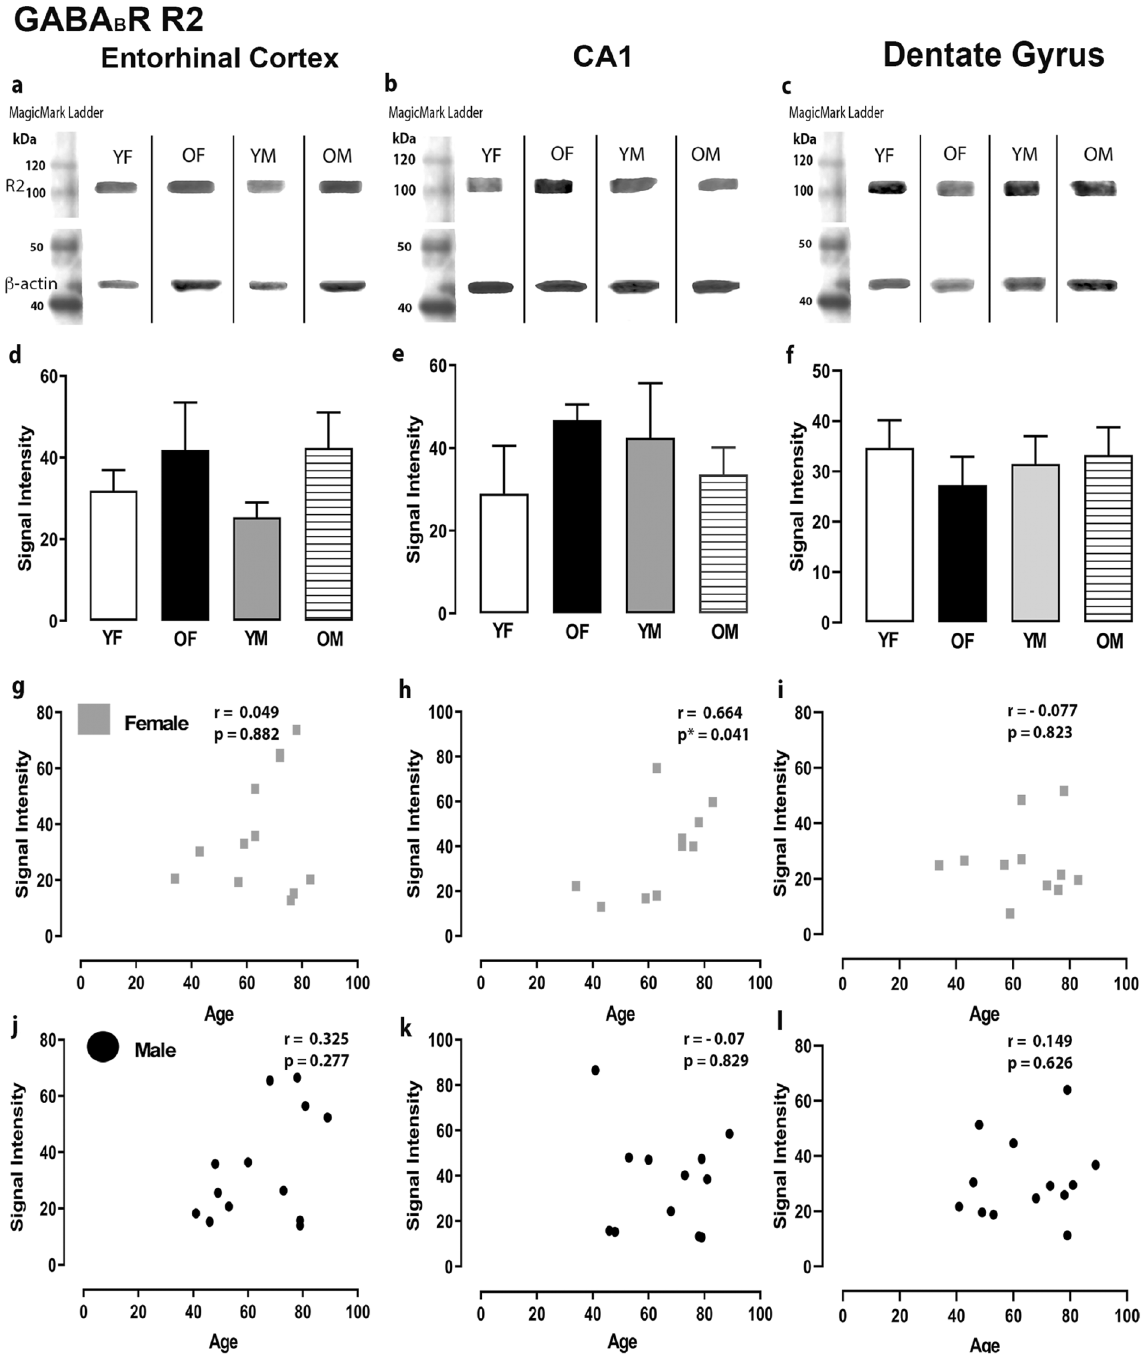
Figure 5. Expression of the GABA B R R2 subunit in the entorhinal cortex, hippocampal CA1 region and dentate gyrus. ( a,b,c ) Representative immunoreactive Western Blot bands from younger female (YF), older female (OF), younger male (YM) and older male (OM) tissue homogenates of the ECx, CA1 and DG regions, following incubation with GABABR R2 antibody. GABA B R R2 and corresponding β-actin band (R2 band size - ~105kDa, β-actin band size ~ 42 kDa) are shown. Each lane was loaded with 20µg of protein. ( d,e,f ) Signal intensity graphs for each group comparing GABA B R R2 Western Blot band was measured and normalised to their corresponding β-actin signal for each age group. The data is graphed as mean ± SEM (N = 4-7). ( g,h,i,j,k,l ) Correlation graphs for males and females plotting the relationship between age and signal intensity of GABA B R R2 bands (p * ≤